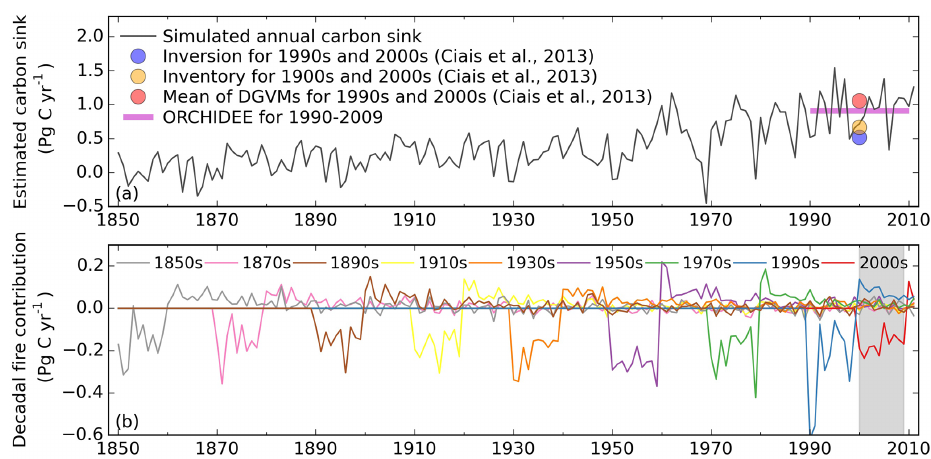
Figure 6. Panel ( a ): annual NBP (NEP minus fire emissions) from the reference fireON simulation for 1850–2011. The terrestrial carbon sink estimates for the 1990s and 2000s by other sources (Ciais et al., 2013) are also presented for comparison. Panel ( b ): the fire effects on NBP by switching off the fire module in a decadal sequence for 1850–2009, i.e., the contributions of decadal fire cohorts (NBP by fireON minus that by decadal fireOFF simulations according to Eq. 4). As the temporal patterns for different decades are similar (i.e., fires are a carbon source term for the decade when fire occurred and a sink term afterwards), curves for every other decade since the 1850s are shown for clarity. The shaded rectangle indicates the 2000–2009 decade, which is our quantification target